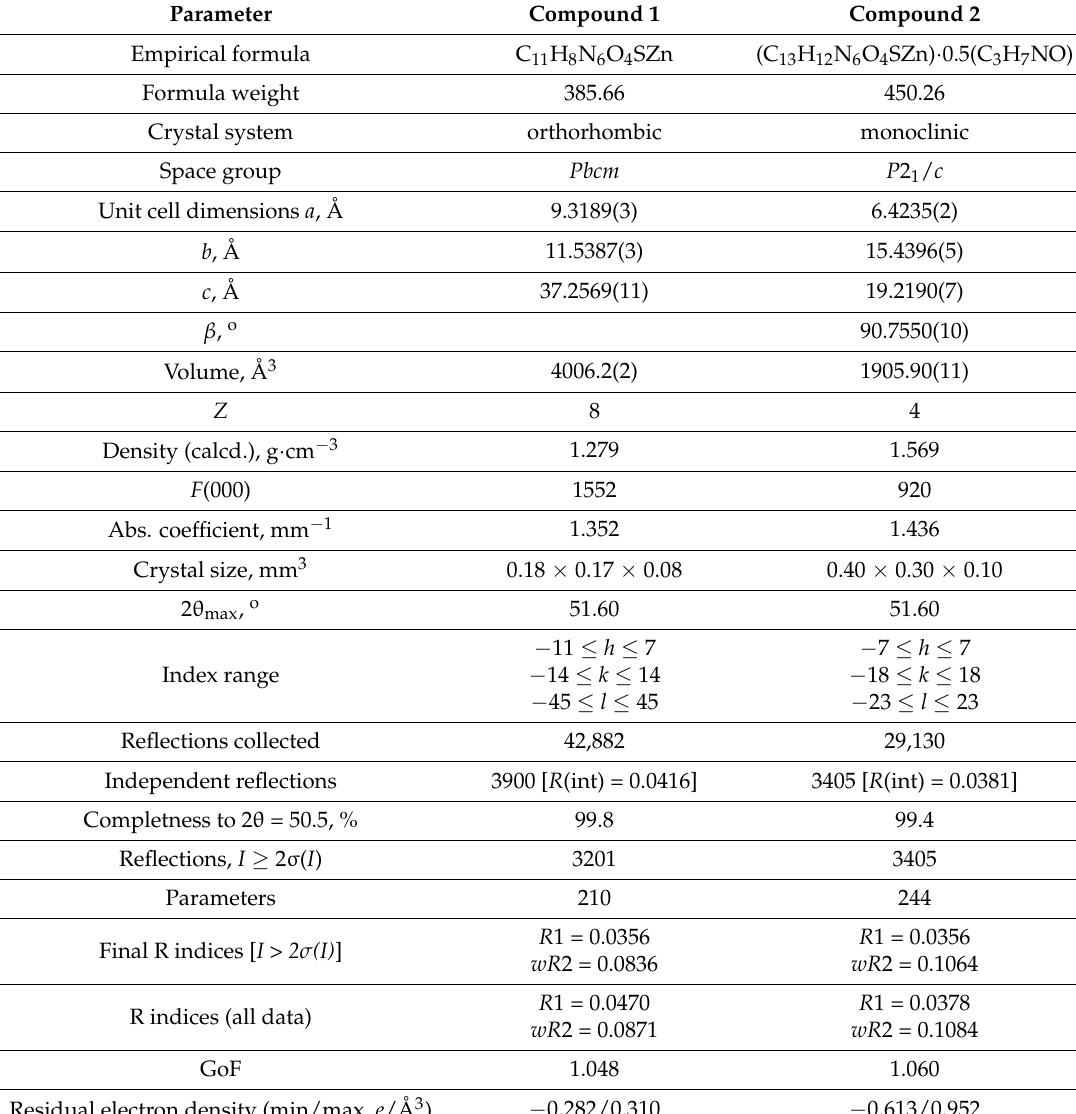
Table 2. Crystallographic data for compounds 1 and 2